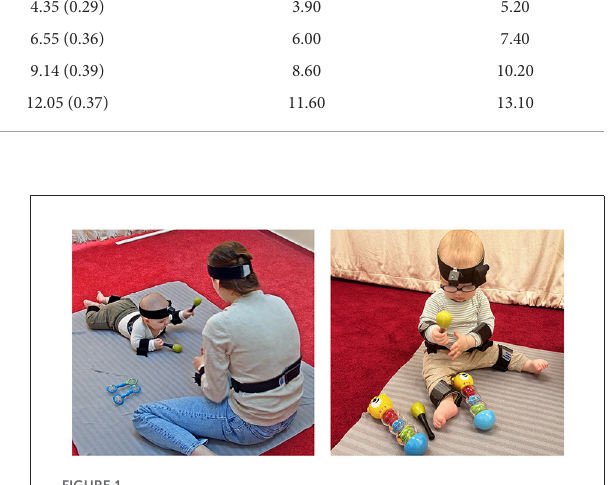
FIGURE1 Photos of the toys used in the rattle-shaking play at T1 and T2 (left) , T3 and T4 (right) . Signed permission of the caregiver was acquired for the publication of the